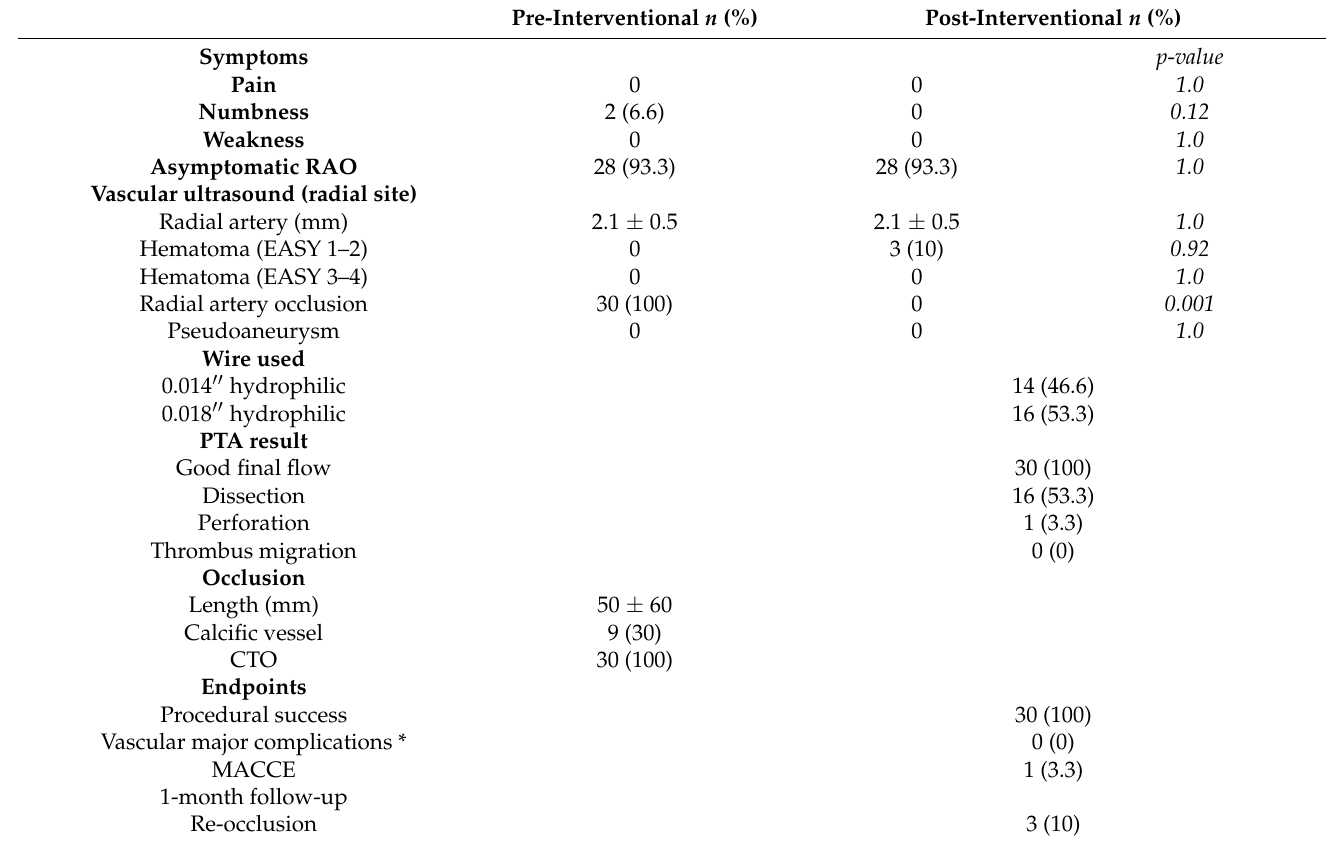
Table 2. Procedural results and outcomes. Vascular major complication was defined as